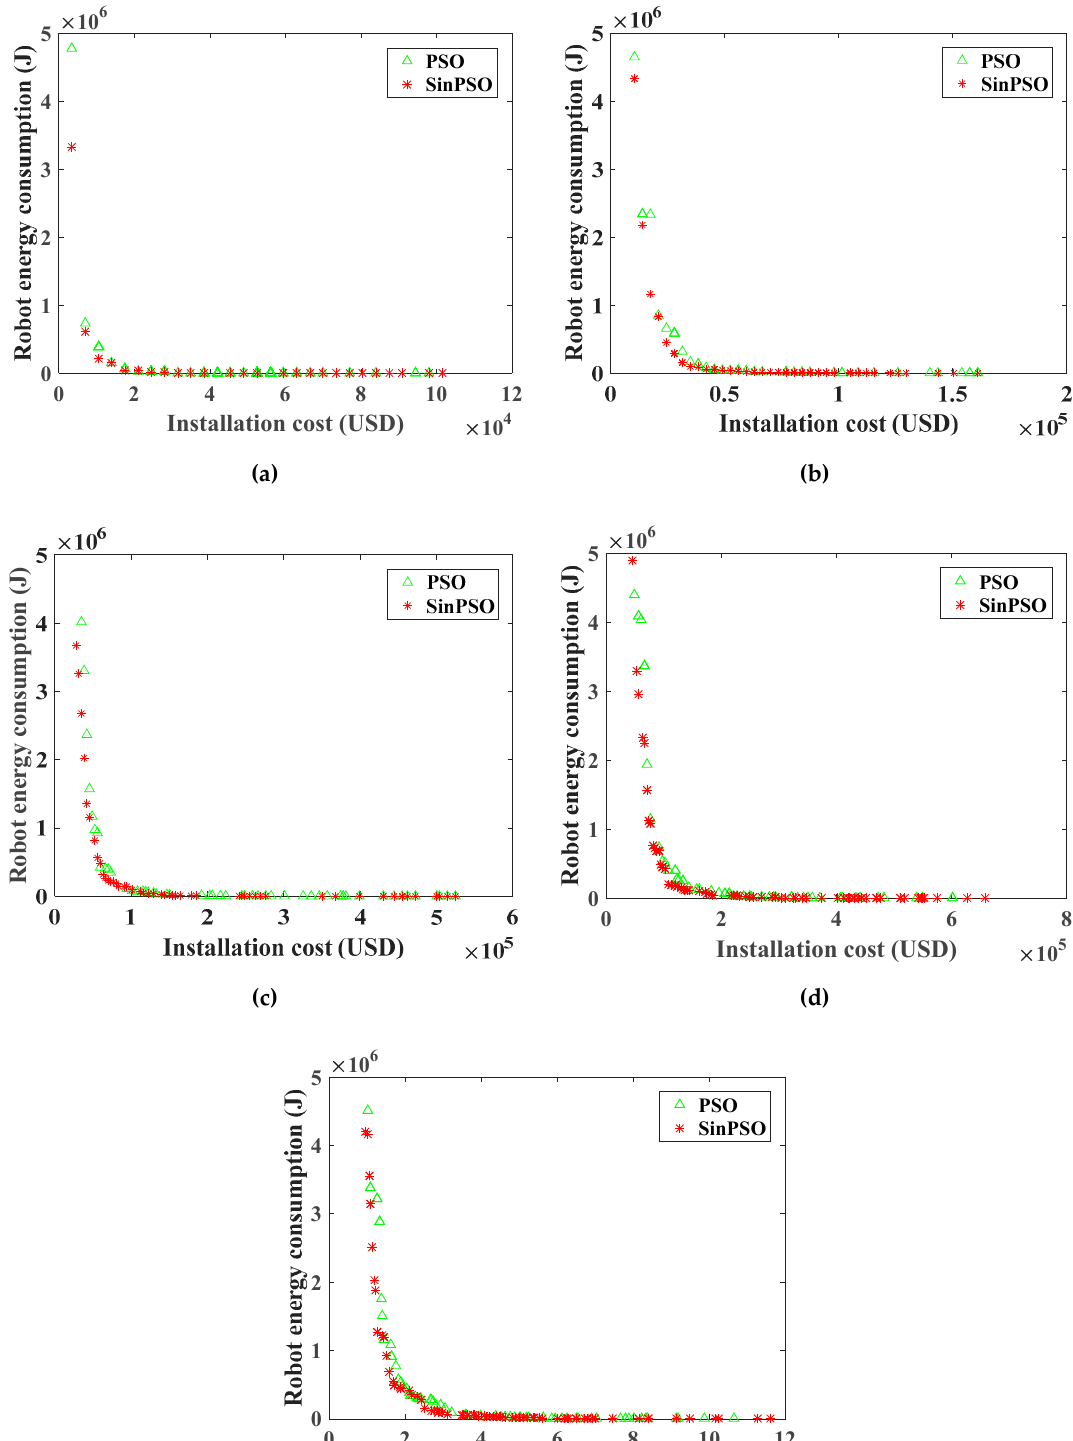
Figure 9. Pareto frontier comparison of deployment cost and optimization objective function of robot energy consumption for WRN by PSO and SinPSO: ( a ) the number of towers is 50; ( b ) the number of towers is 100; ( c ) the number of towers is 200; ( d ) the number of towers is 300; ( e ) the number of towers is 500.